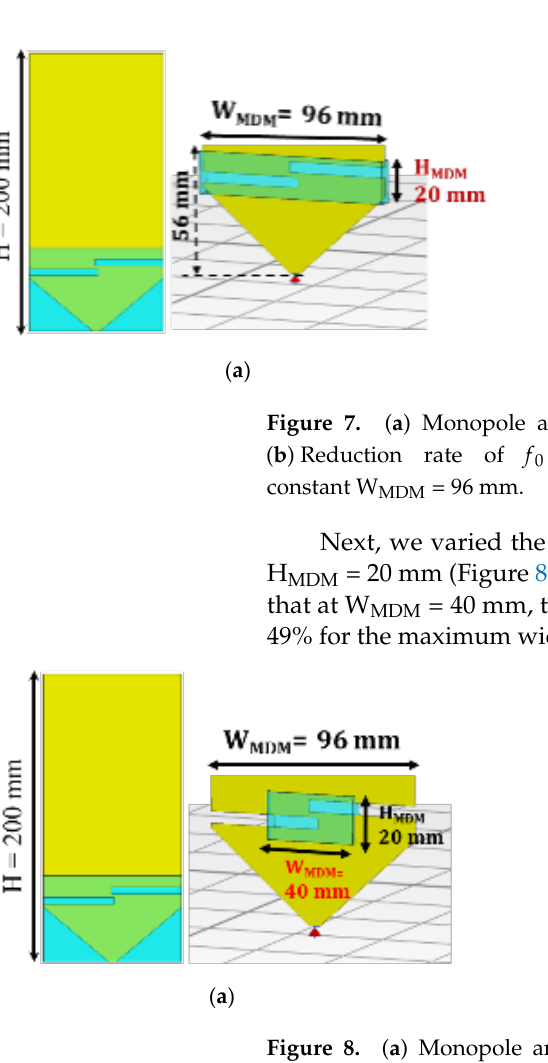
Figure 8. ( a ) Monopole antenna of the height 200 mm with two slots of the width 50 mm. ( b ) Reduction rate of f 0 and µ eff in function of P-MDM width W MDM with a constant H MDM = 20 mm.